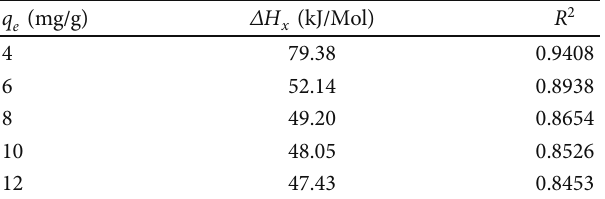
Table 6: Isosteric heat of adsorption